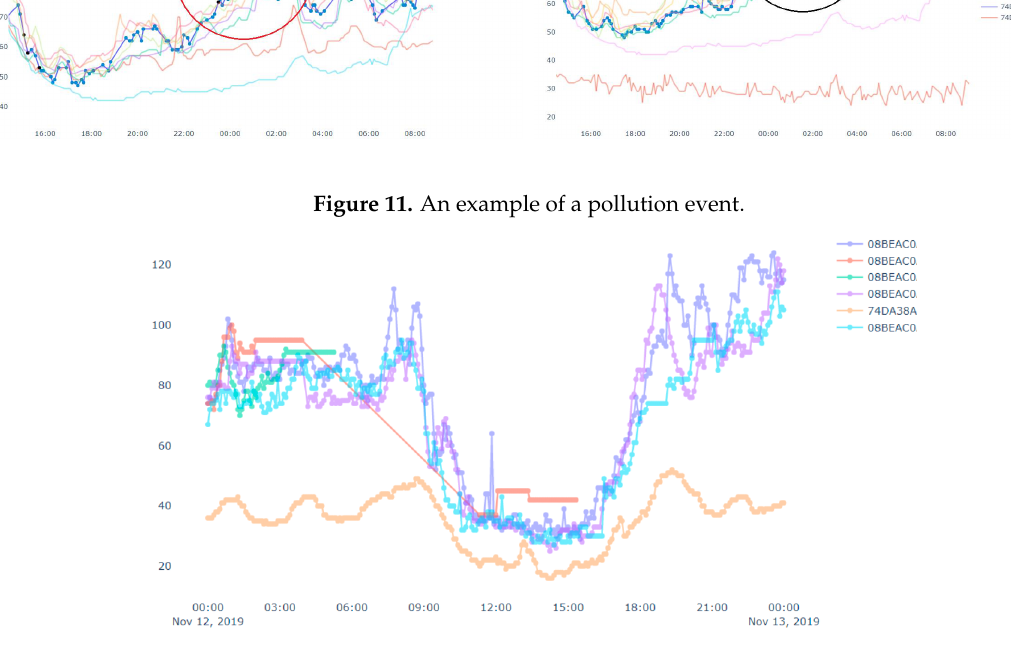
Figure 12. A case study of a fire event with PM2.5 sensors’